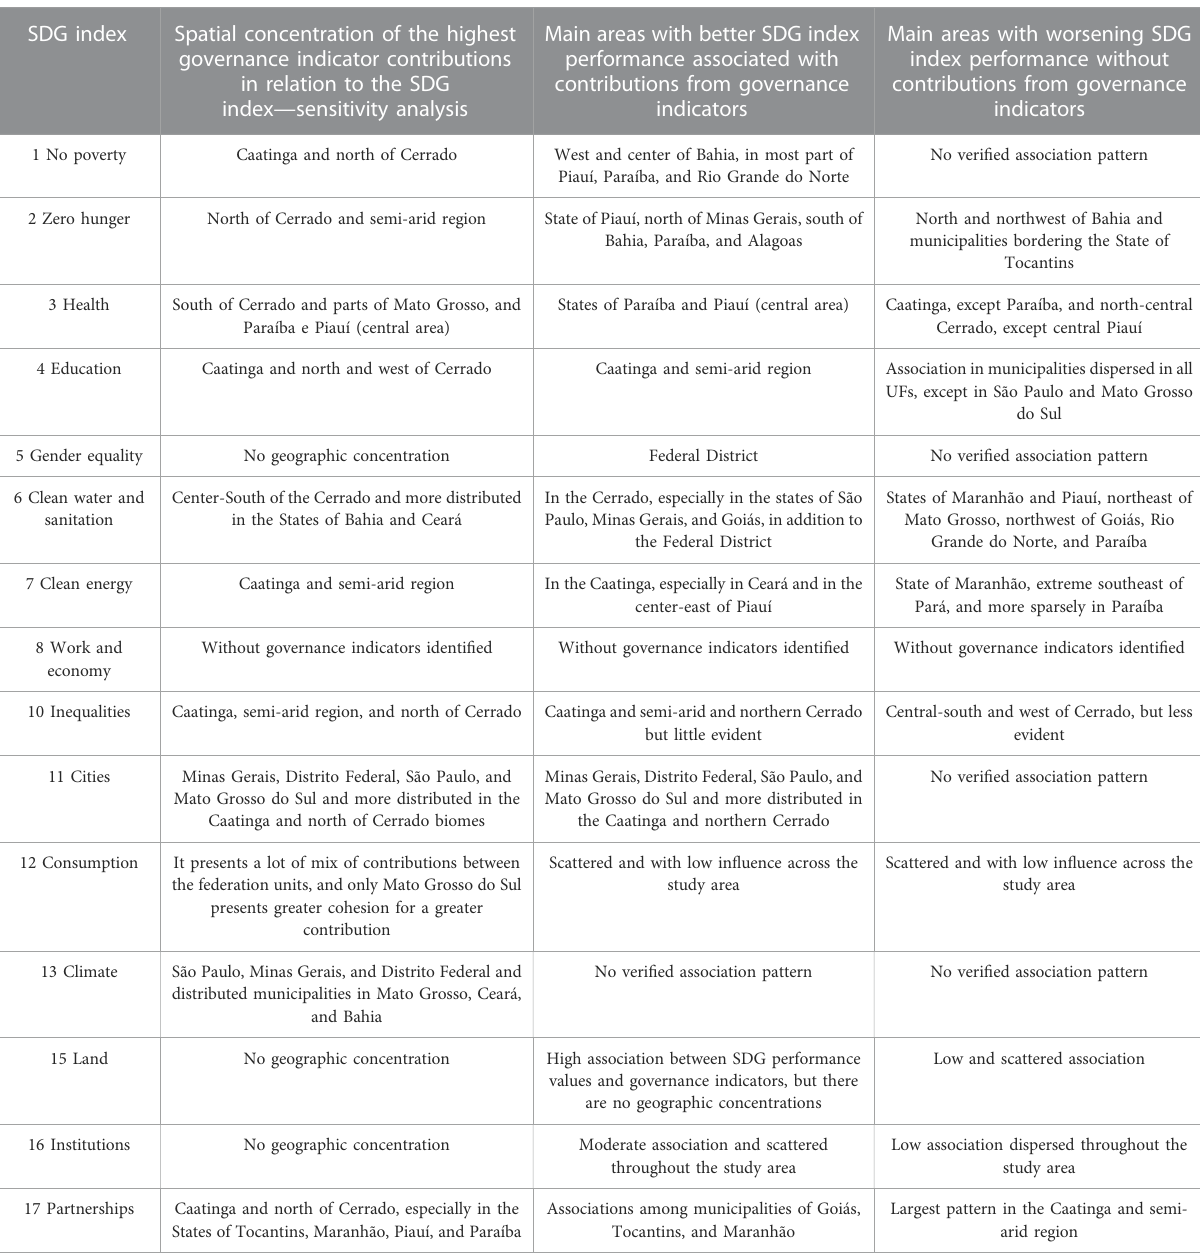
TABLE 4 Sensitivity analysis patterns for governance indicators for each